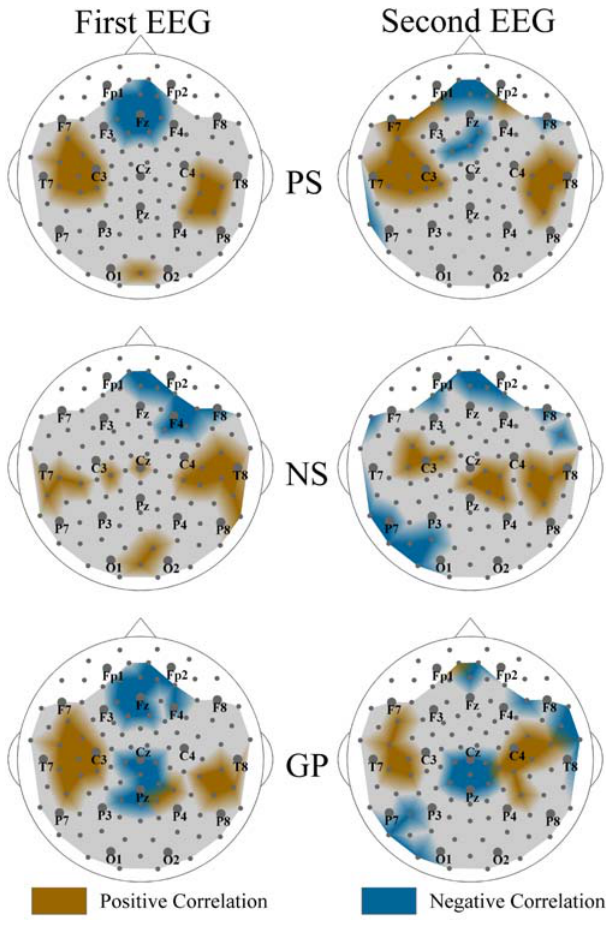
Figure 5. Correlation between synchronization and SZ symptoms. The topographies of correlations between the S-estimator changes in patients and their symptoms as measured by the Positive Symptom Scale (PS), Negative Symptom Scale (NS), and General Psychopathology Scale (GP) are shown. The regions where the significant correlations are direct or inverse are marked in brown or turquoise, respectively. There are no significant correlations in the gray regions.